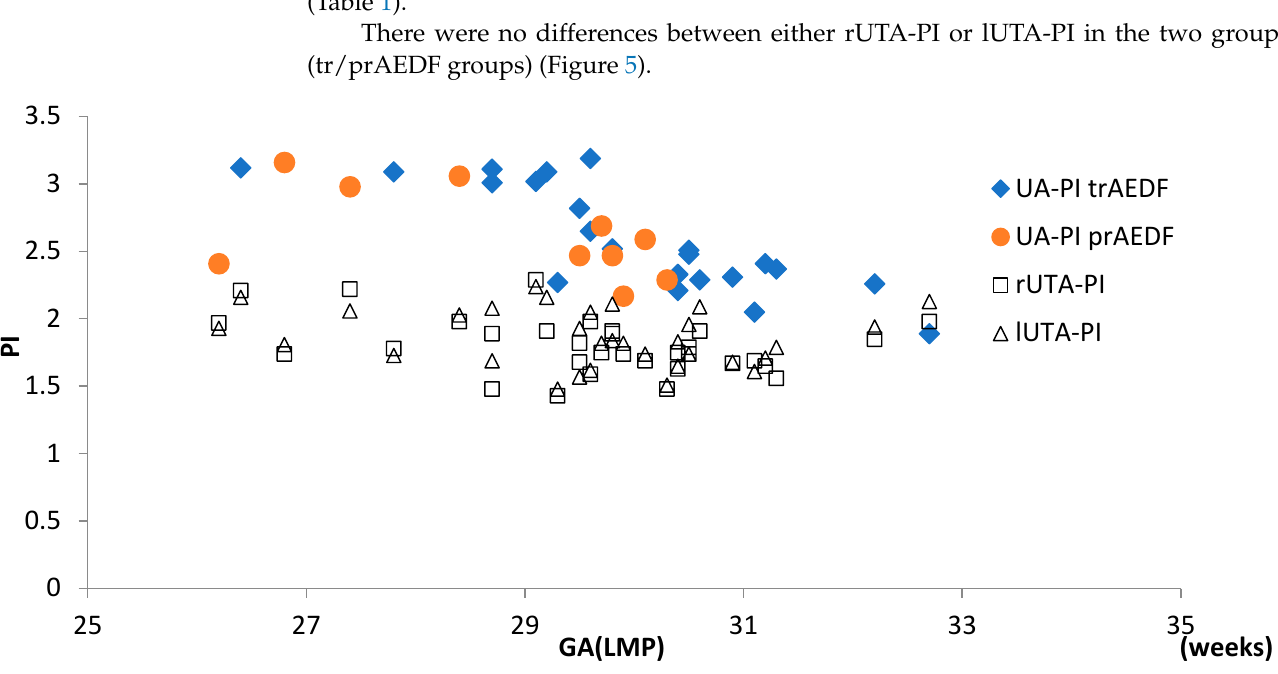
UTAs ‐ PIs showed no significant variation during the 5 days of observation in both groups